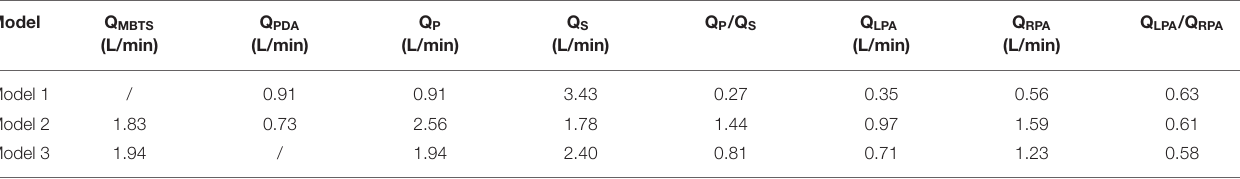
TABLE 2 | Flow distribution.